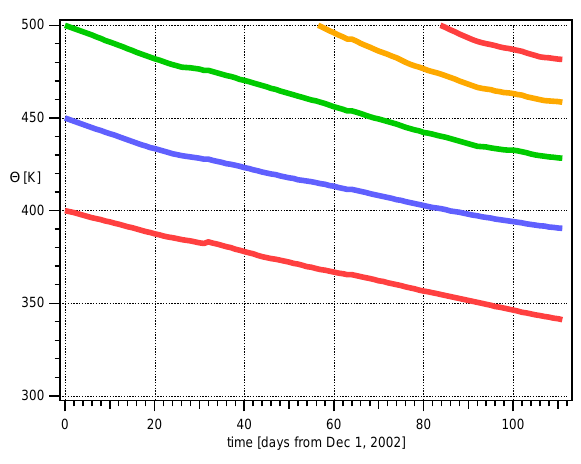
Fig. 6. H 2 O data plotted versus the potential temperature. Small grey circles show FISH data during the EuPLEx/AVC campaigns, large black circles mark the H 2 O entry values given by Krebsbach (2005) and the black line denotes the H 2 O entry fit, H 2 O entry ( θ ) , used to derive tropospheric boundary values.